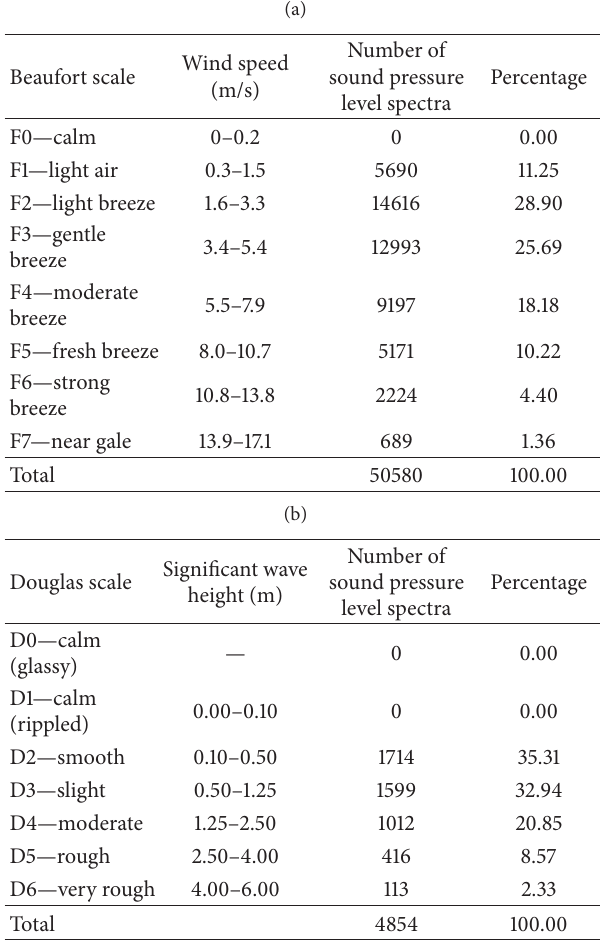
Table 4: Number of available sound pressure level spectra divided into (a) Beaufort wind speed and (b) Douglas seas state classes on the basis of 5-minute running average of wind speed and significant wave height measurements acquired by the anemometer and the wave meter system on board the buoy,